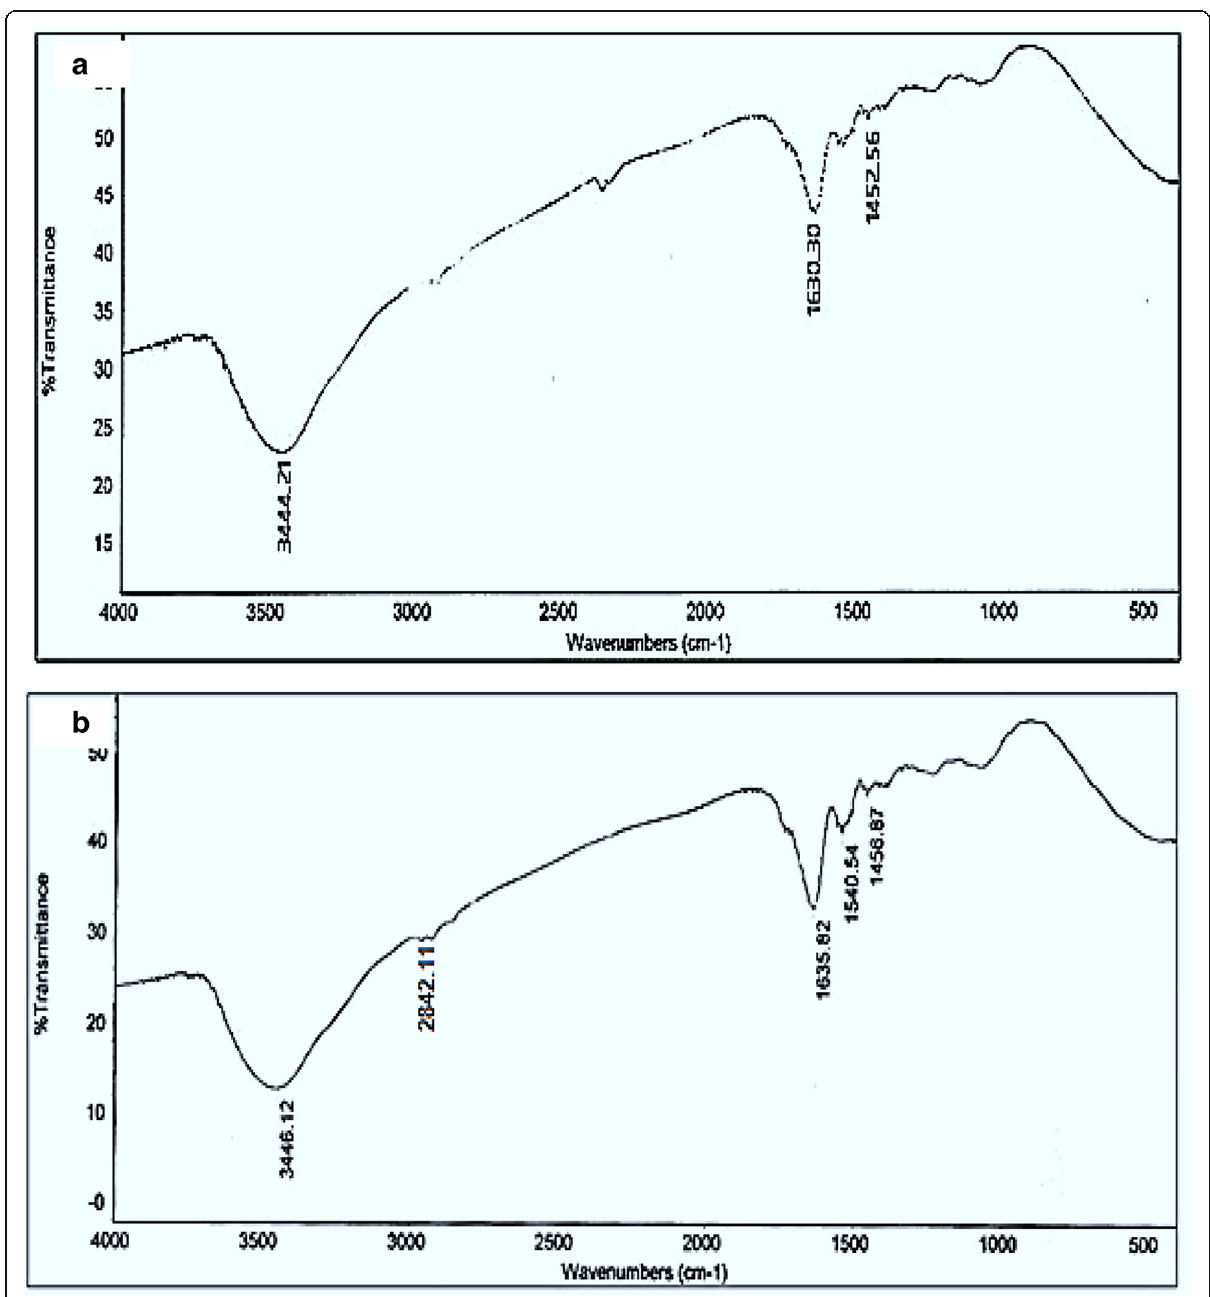
Fig. 10 FTIR spectrum of native biosurfactant ( a ) and biosurfactant interacted with wastewater ( b